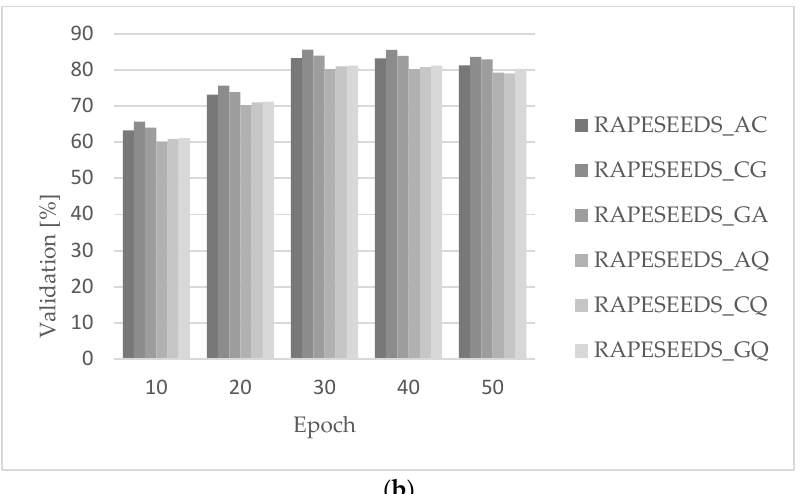
Figure 5. Accuracy of models depending on the number of epochs: ( a ) in the training process, ( b ) in the validation process. Table 4. Average accuracy and loss values of the training and validation process for CNN models in 30